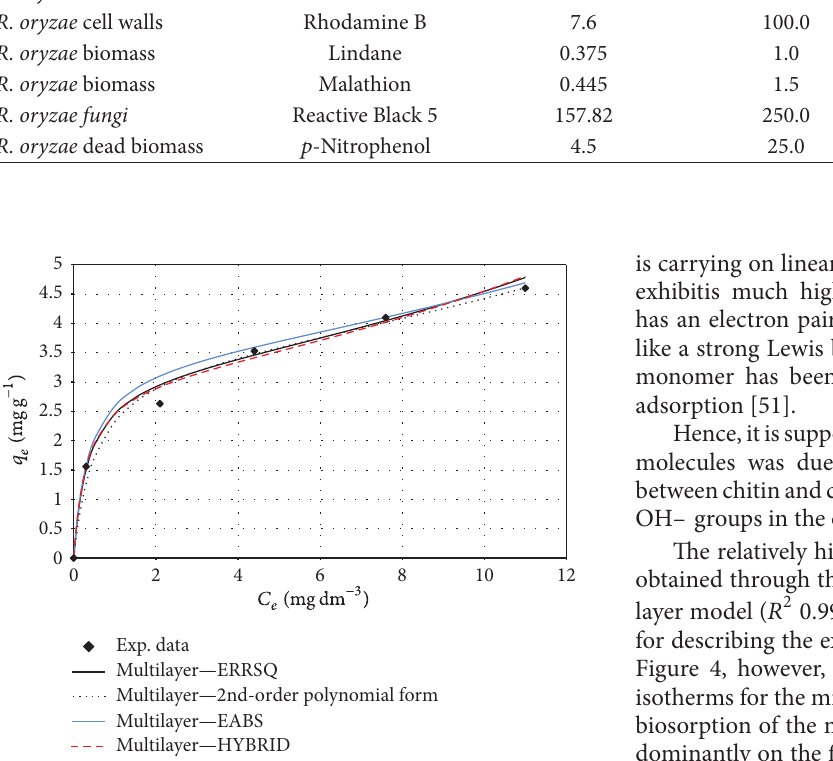
F5:ExperimentalequilibriumdataandFritz-Schlunder(four- parameter model) isotherms of p -NP biosorption on R. oryzae dead biomass